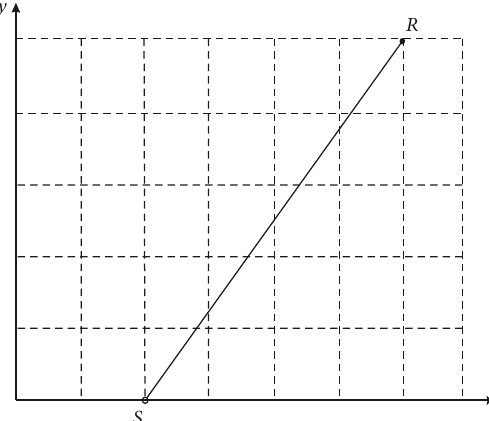
Figure1:CoordinatesystemusedintheRadonformula,where 𝑟, 𝑧, 𝑙 refer to the length, and 𝜃, 𝜙 refer to the angle.